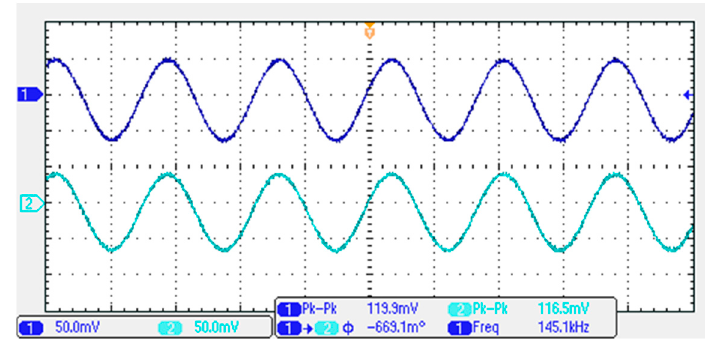
Figure 19. The experimental time-domain voltage input (channel 1, blue line) and voltage output (channel 2, cyan line) signals of the BP filter of V o3 output terminal.